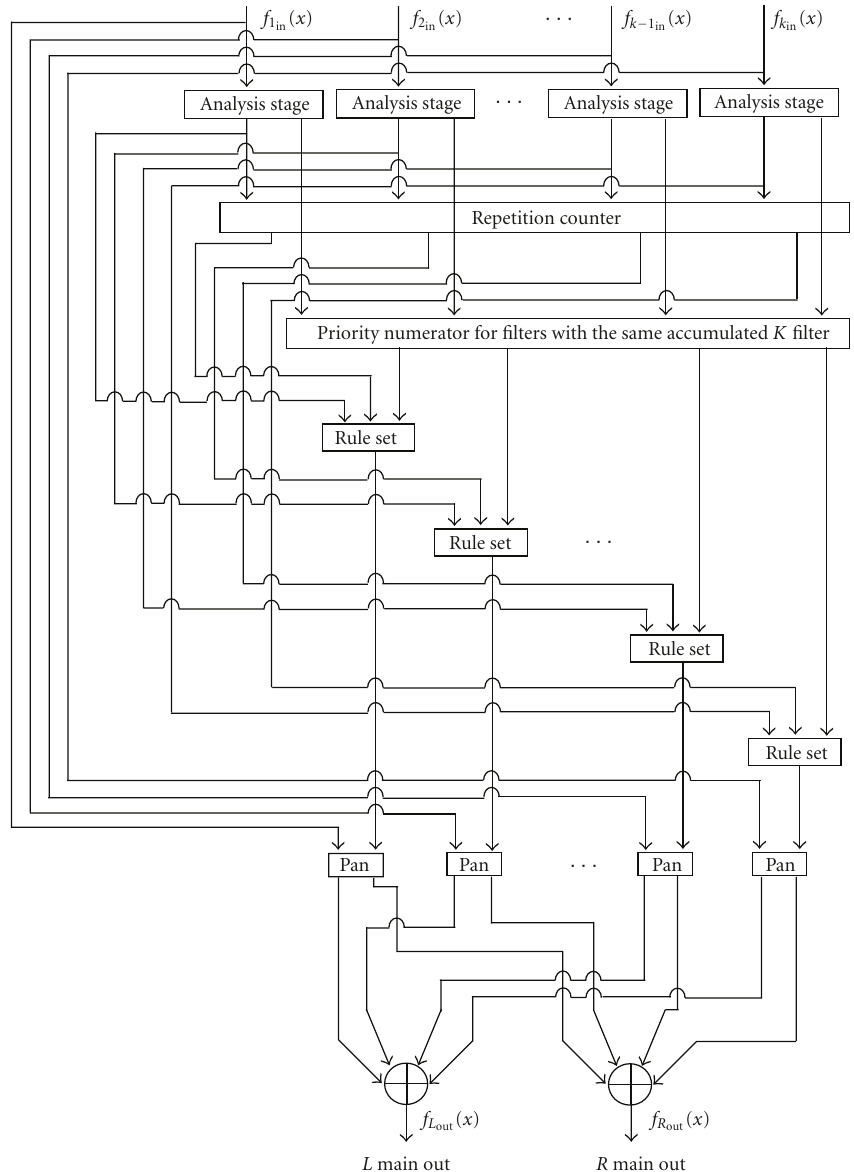
Figure 5: Block diagram of the automatic panner constrained control rules algorithm for K input